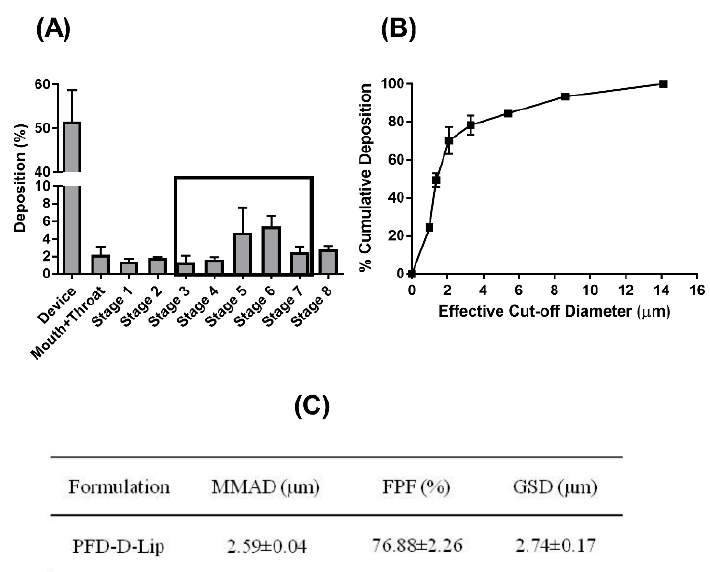
Figure 4. In-vitro deposition profile of PFD–D-Lip. ( A ) Aerosol dispersion performance as % deposited on each stage of the Next Generation Impactor™ (NGI™) for PFD–D-Lip. For Q = 15 L/minute for 4 min. The effective cutoff diameters (D 50 ) for each impaction stage are as follows: Stage 1 (14.1 µ m), Stage